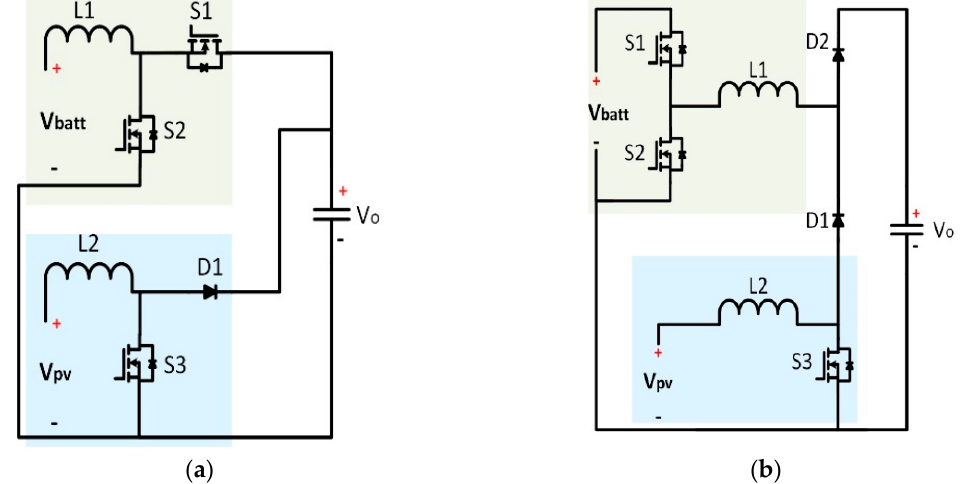
Figure 3. Suggested topologies of the multi-port converter ( a ) Boost-Boost MPC; ( b ) proposed topology.